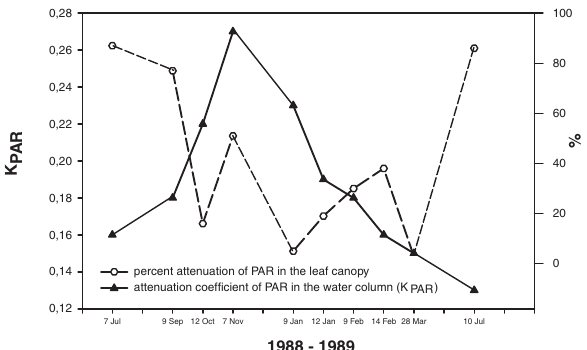
percent attenuation of PAR in the leaf canopy attenuation coefficient of PAR in the water column (KPAR)